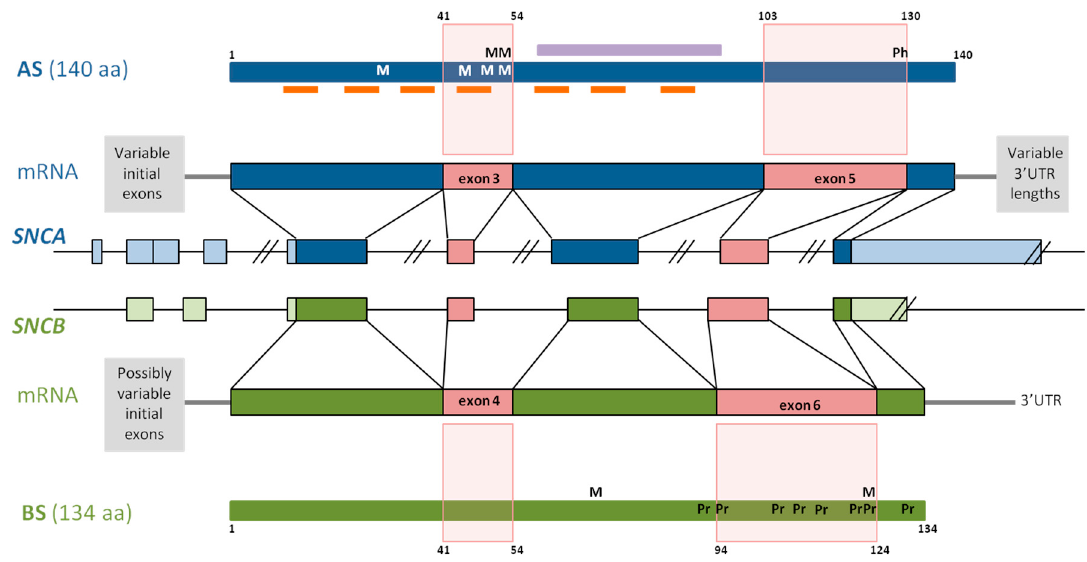
Figure 1. Schematic representation of the SNCA (blue) and SNCB (green) genes. Coding regions are colored in dark and untranslated regions in light. Exons affected by alternative splicing are colored in pink. The corresponding transcripts are shown above or below their respective genes, as are the resulting proteins. Light pink squares mark the protein regions that are deleted as a result of in-frame splicing. Short orange bars represent the seven imperfect repeats, the violet bar represents the non-amyloid component (NAC) domain. M, shows the location of the different mutations in both α -synuclein (AS) and β -synuclein (BS); Ph, is the main phosphorylation site at S129 in AS; Pr, proline residues along the C-terminal of BS.